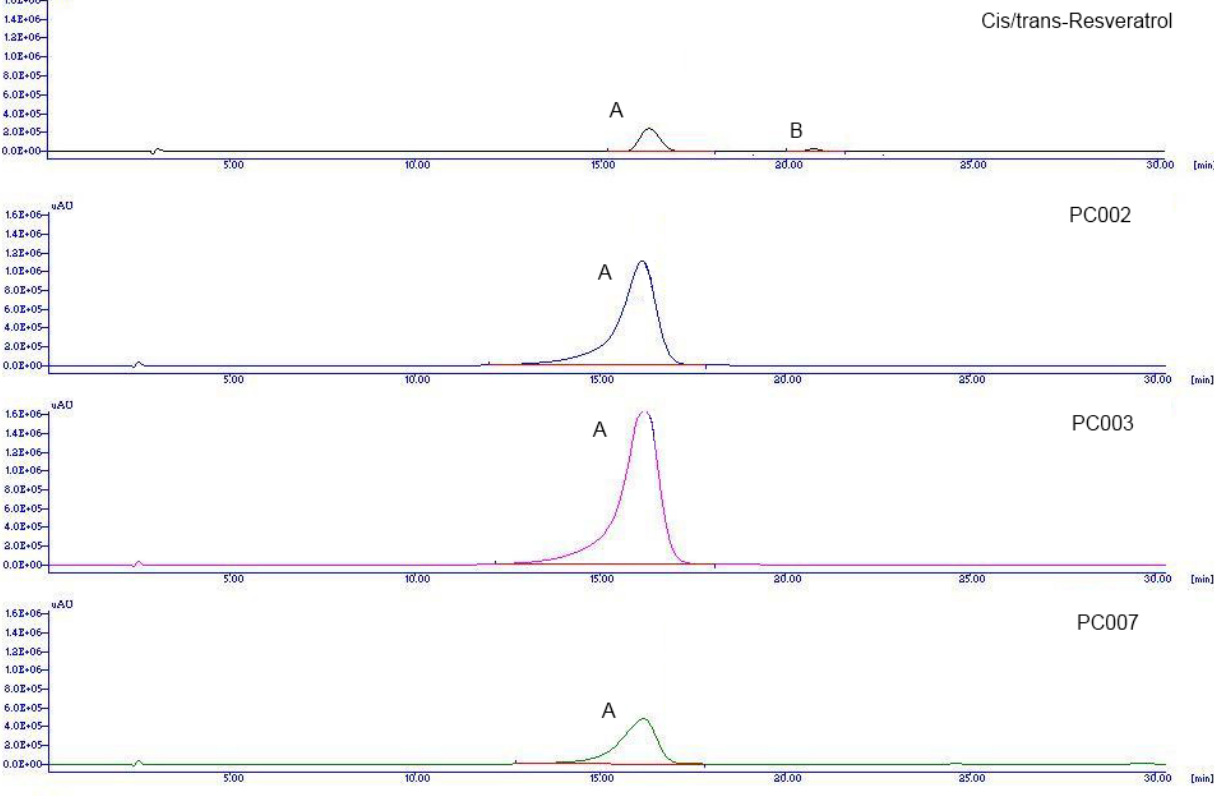
A: trans -Resveratrol; B: cis